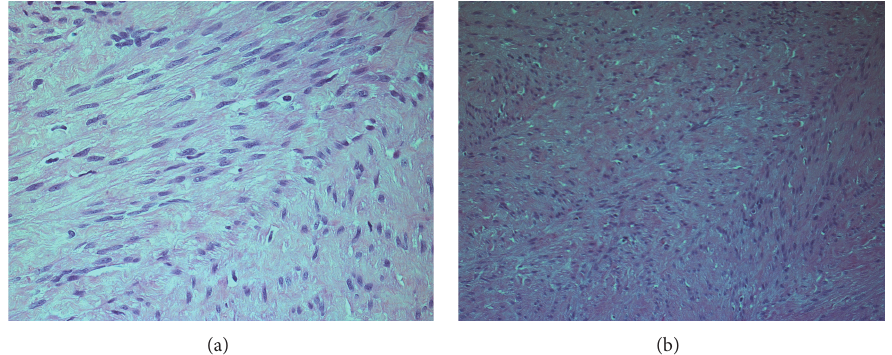
Figure 1: (a), (b) Microscopy showing a benign tumor composed of sheets and fascicles of oval to spindle shaped cells with abundant dense cytoplasm and areas of